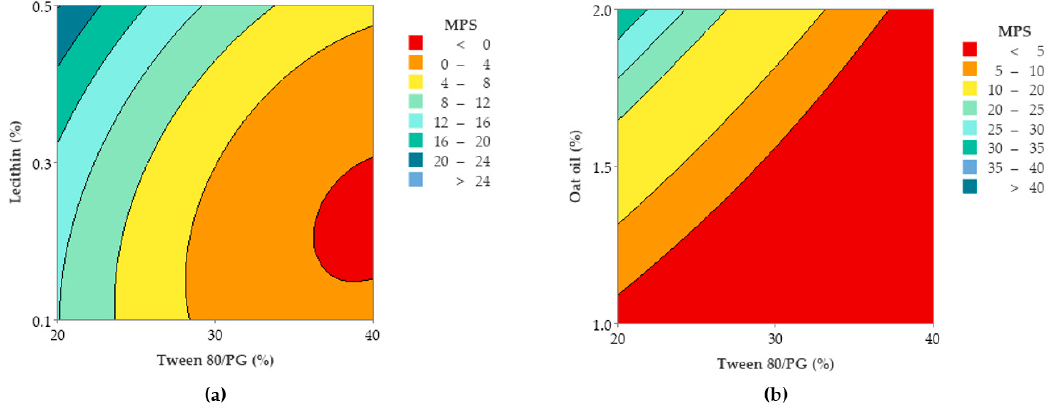
Figure 17. Contour plots representing Ds response (Y 2 ) variation as function of: ( a ) Tween 80/PG (%), Lecithin (%), and ( b ) Tween 80/PG (%), Oat oil (%).